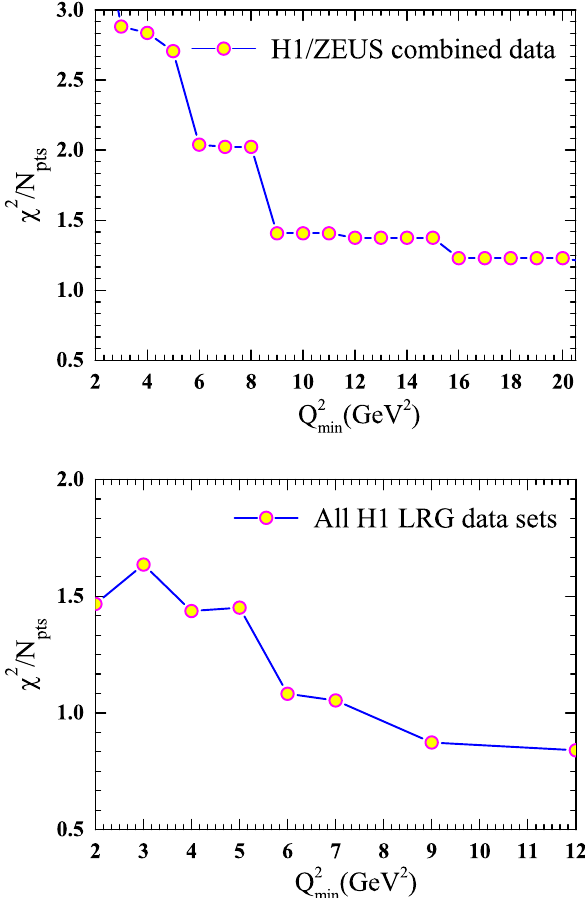
Fig. 3 Dependence of χ 2 / N pts on the minimum cut value of Q 2 H1/ZEUS combined data (up) and all H1 LRG data sets (down)